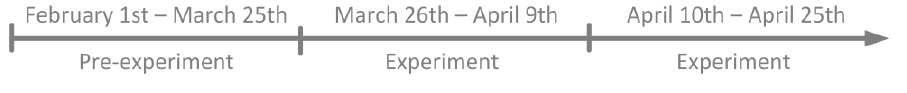
Fig. 3. Experiment time